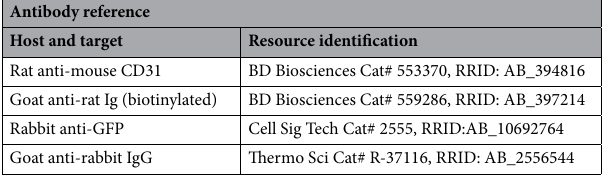
Table 2. Antibody